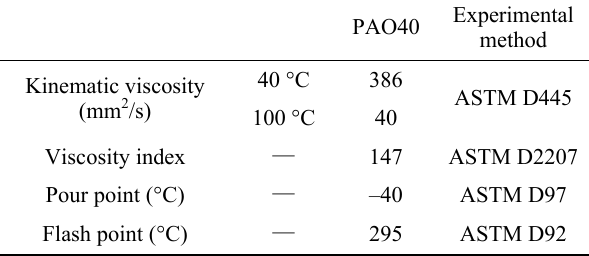
Table 2 Physical properties of PAO40.